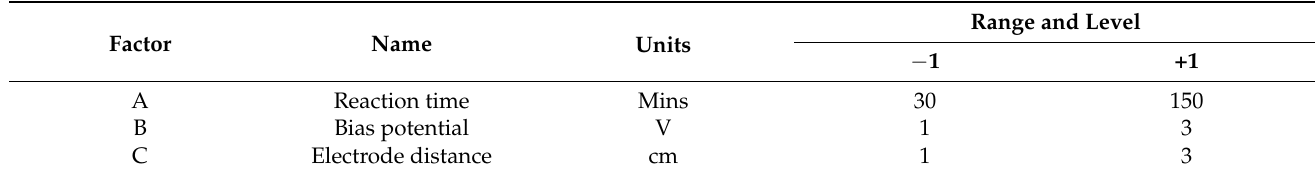
Table 2. Experimental ranges and levels of the factors used in the factorial design.